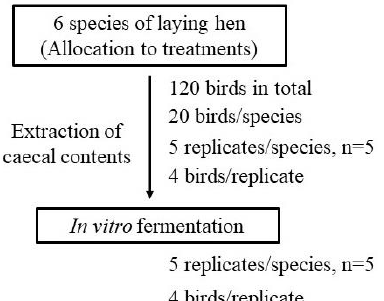
Figure 1. The experimental design, showing treatments and replicates.